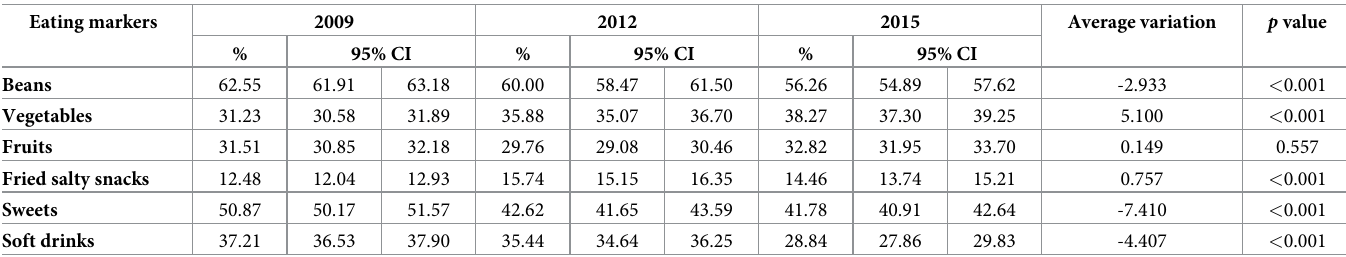
� adjusted for the variables age, gender, race/skin color, macro regions and school administrative